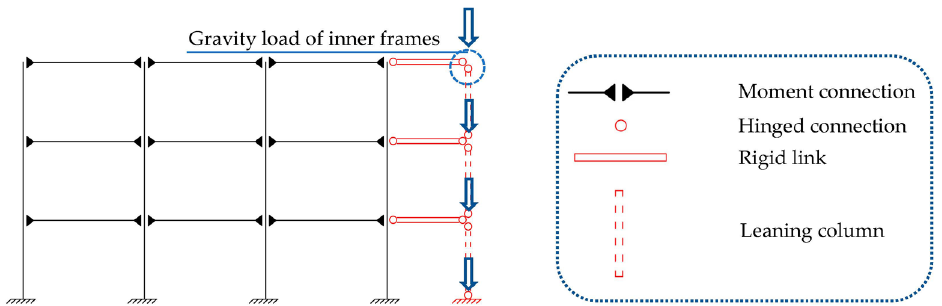
Figure 5. Illustration of P- ∆ column in 3-story FE model.